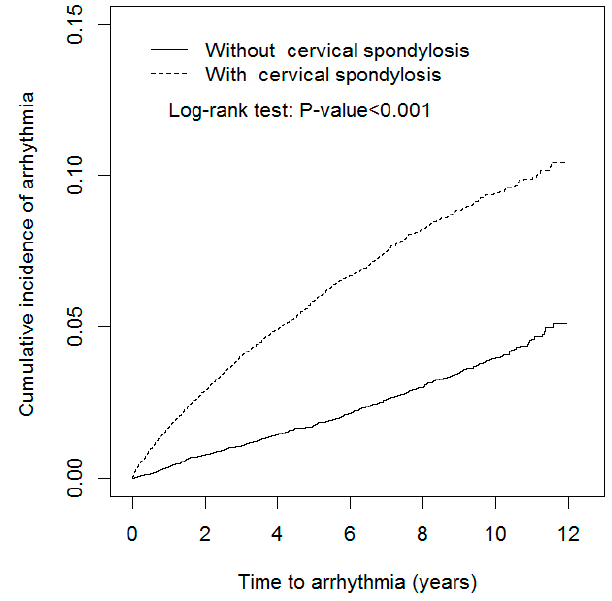
Figure 1. Cumulative incidence of arrhythmia in propensity-score matched patients with and without cervical spondylosis.